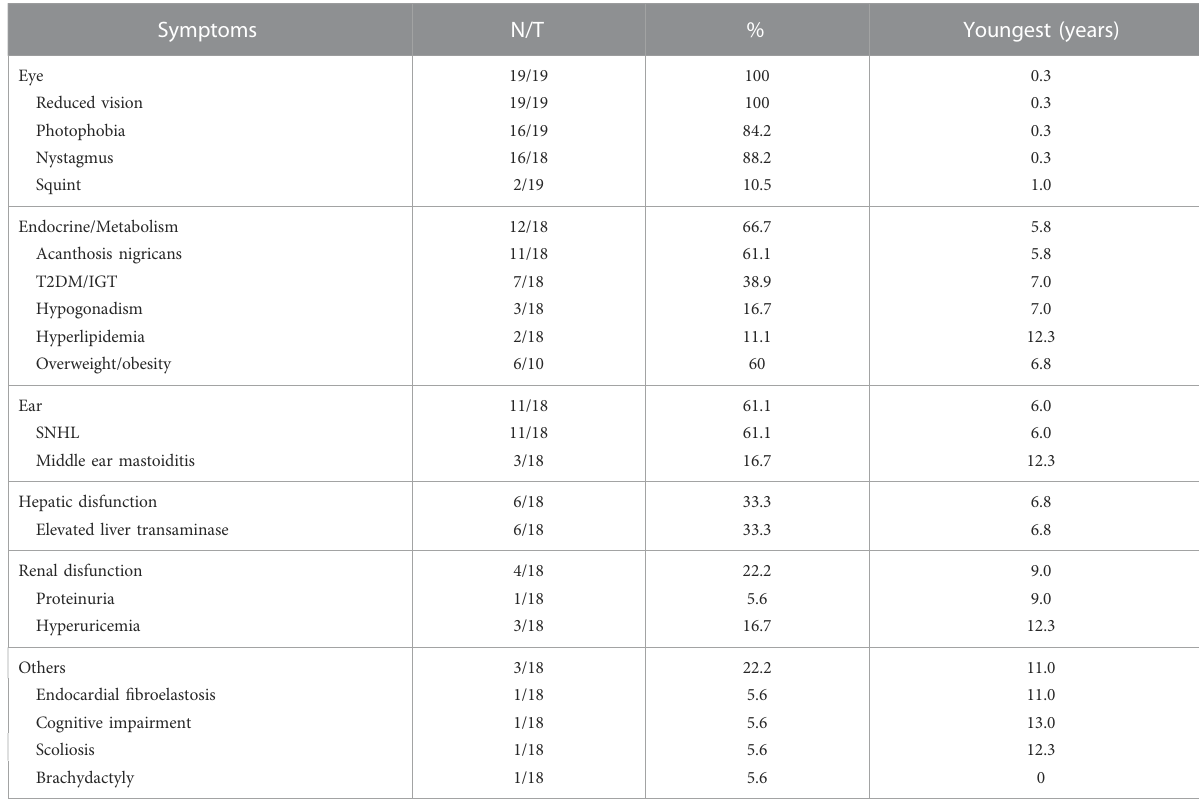
TABLE 3 Presenting symptoms in the patients with AS.